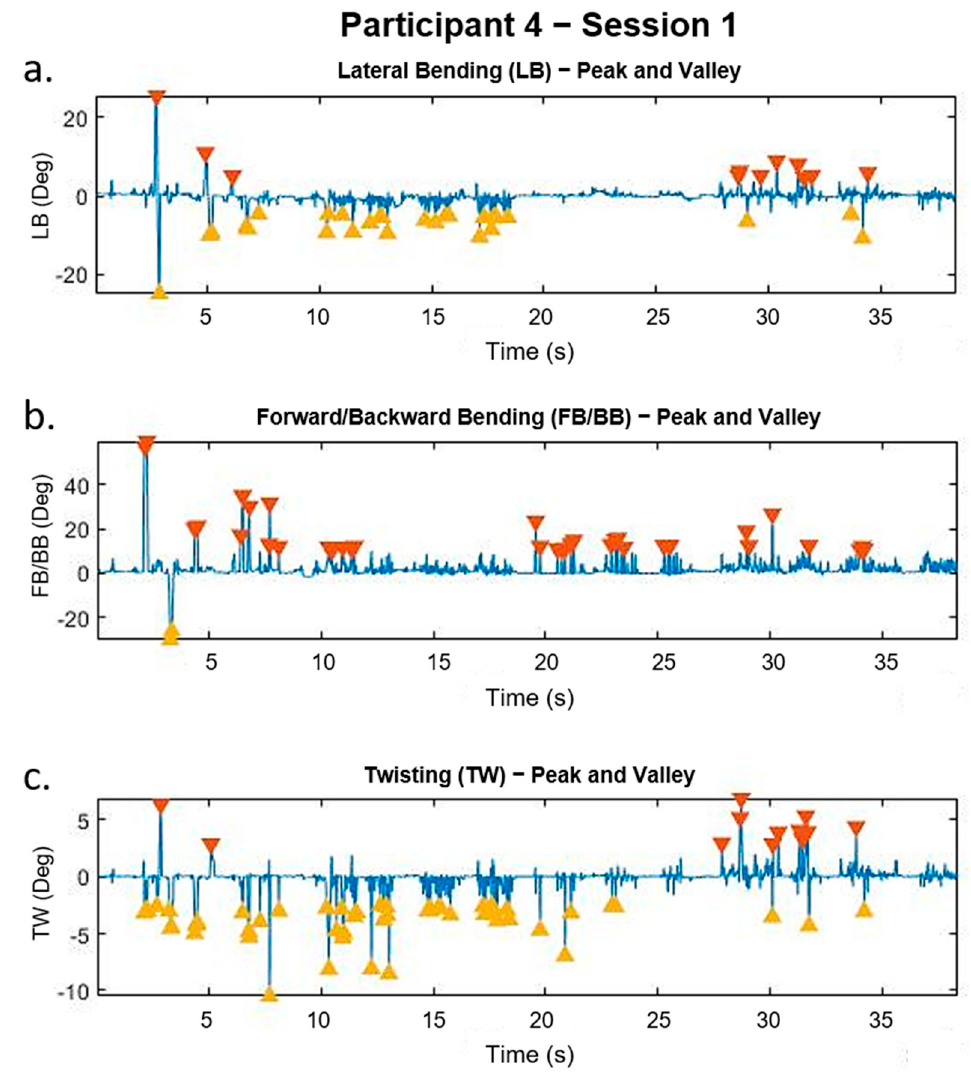
Figure 5. Peaks and valleys in the data of a single participant using the findpeaks function: ( a ) lateral bending (LB), ( b ) forward/backward bending (FB/BB), and ( c ) twisting (TW).